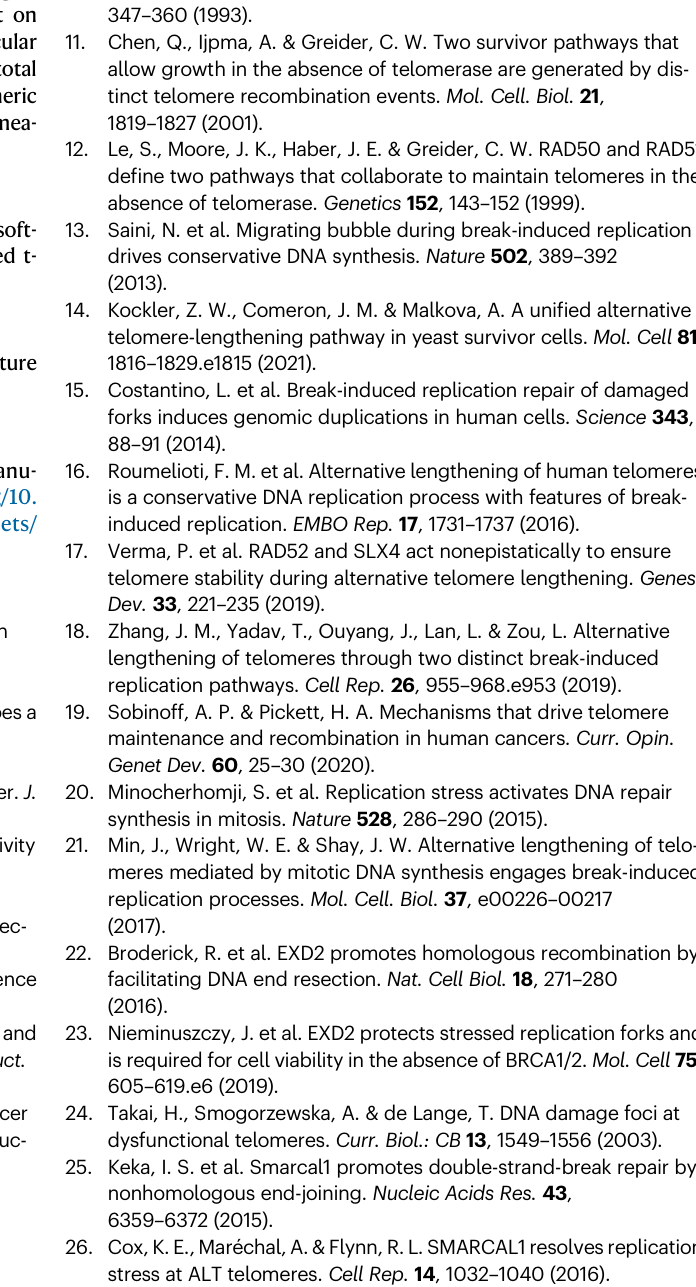
Fig. 6 | EXD2-de fi cient U2OS cells are synthetic sick upon depletion of factors that promote BIR-mediated ALT DNA synthesis. a Colony formation assays in WTU2OSand EXD2 − / − cellstreatedwithsiRNAtargetingBLM,SLX4orcontrolsiRNA (Luciferase). Surviving fraction relative to control is quanti fi ed ( n =4 biologically independent samples examined over 2 independent experiments, statistical sig- ni fi cance was determined by two-sided student ’ s t-test, bars represent +/ − SEM). b Colony formation assays in WT U2OS and EXD2 − / − cells treated with siRNA tar- geting DNA2 or control siRNA. Surviving fraction relative to control is quanti fi ed ( n =6 biologically independent samples examined over 3 independent experi- ments, statistical signi fi cance was determined by two-sided student ’ s t-test, bars represent +/ − SEM). c Colony formation assayin WT U2OS and EXD2 − / − cellstreated with siRNA targeting POLD3 or control siRNA, as indicated. Surviving fraction relative to control is quanti fi ed ( n =8 biologically independent samples examined over 2 independent experiments, statistical signi fi cance was determined by two-